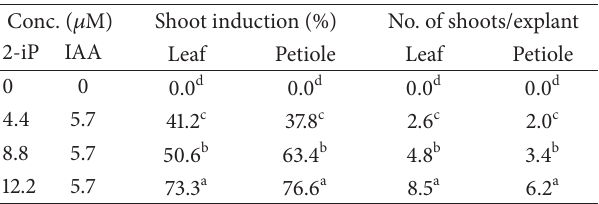
Table 2: Effect of Si and NaCl on adventitious shoot regeneration from leaf and petiole explants of A. multiflora